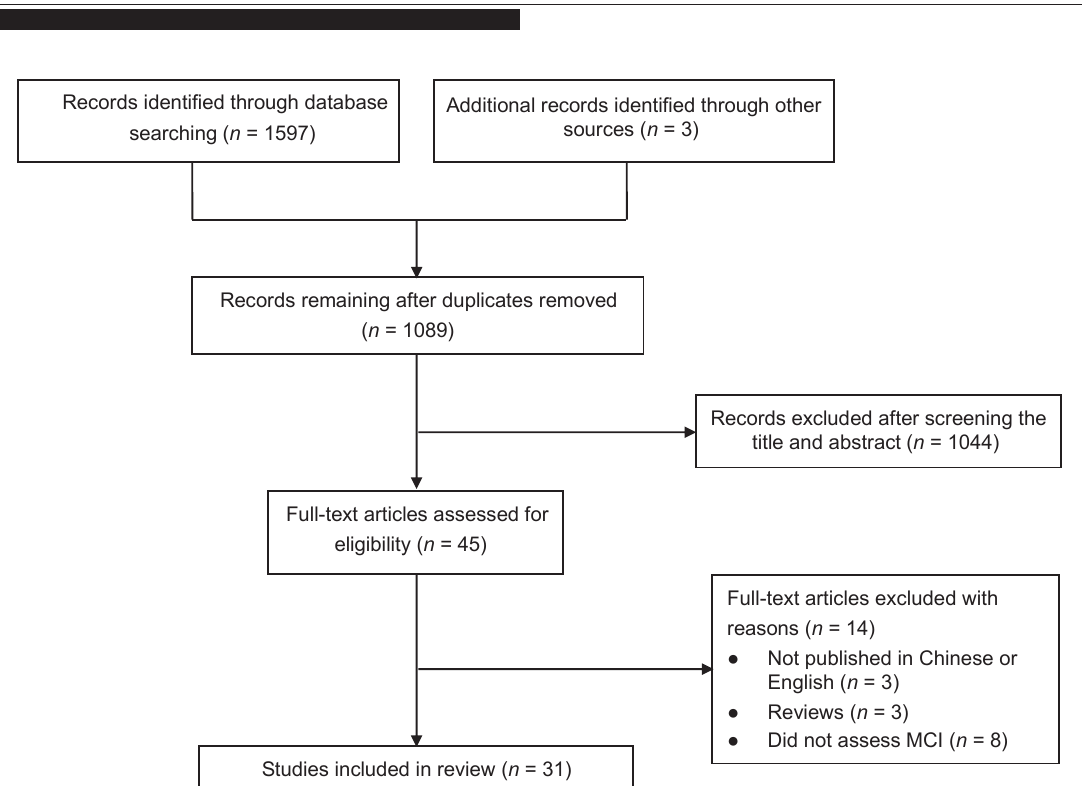
Figure 2. PRISMA flow diagram for included